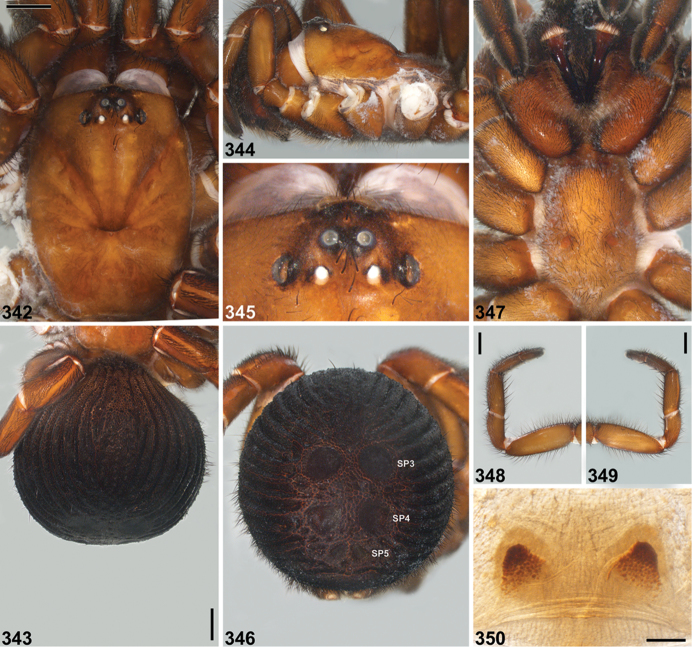

Idiosoma
schoknechtorum sp. n., female (WAM T140765) from SW. of York (Western Australia; AVW). 342–343 Carapace and abdomen, dorsal view 344 Carapace, lateral view 345 Eyes, dorsal view 346 Abdomen, posterior view 347 Sternum, ventral view 348 Leg I, prolateral view 349 Leg I, retrolateral view 350 Spermathecae, dorsal view. Scale bars 2.0 (342–343, 348–349), 0.5 (350). SP3–5 = sigilla pairs 3–5.